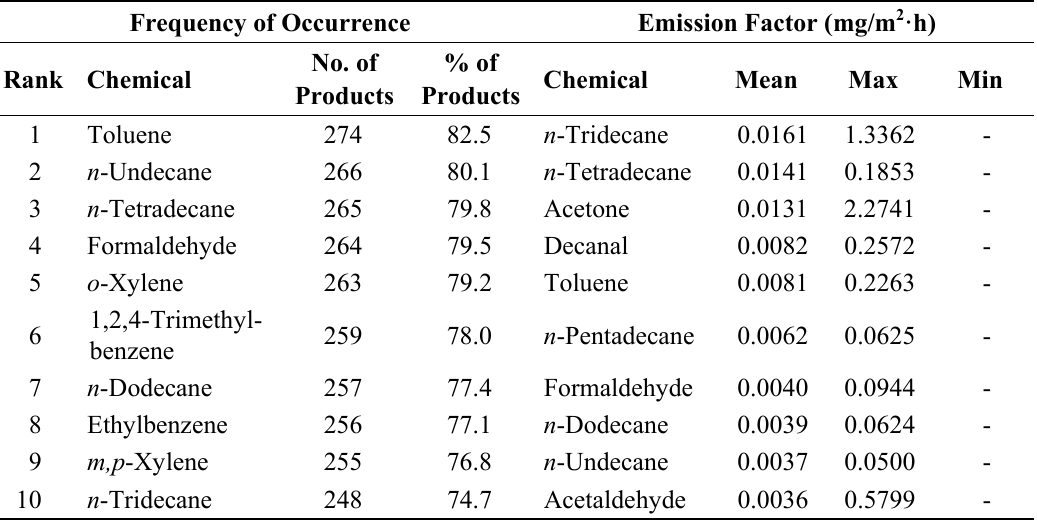
( b ) Table 6. Frequencies of occurrence and emission factors for chemicals evaluated in this